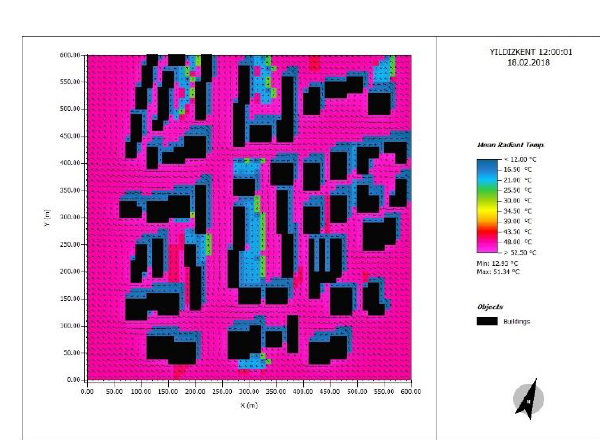
Figure 11. Mean Radiant Temperature for Mahallebasi